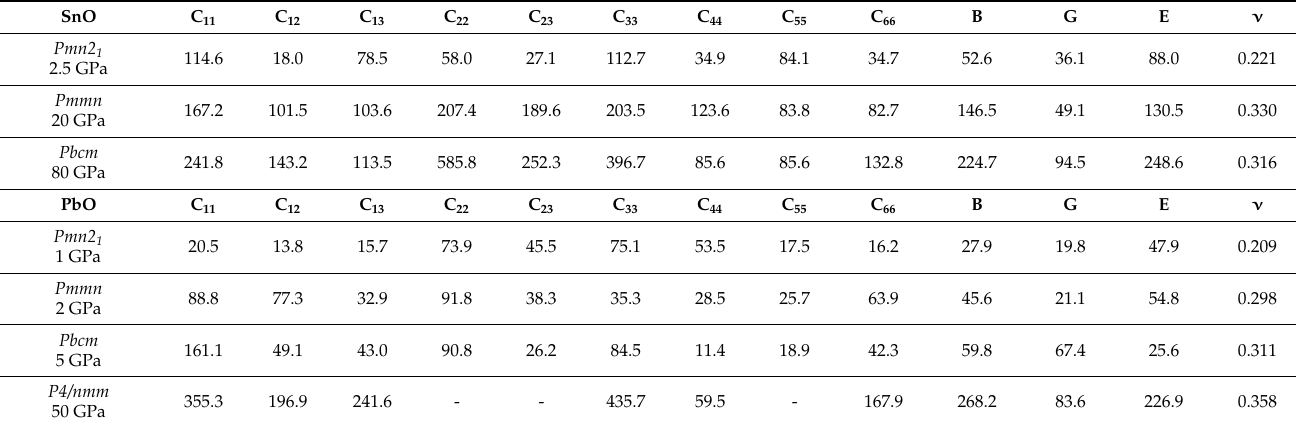
Table 3. Elastic constants C ij (GPa), Voigt–Reuss–Hill average bulk modulus B (GPa), Voigt–Reuss–Hill average shear modulus G (GPa), Young’s modulus E (GPa), and Poisson’s ratio ν of the orthorhombic and octahedral phases of SnO and